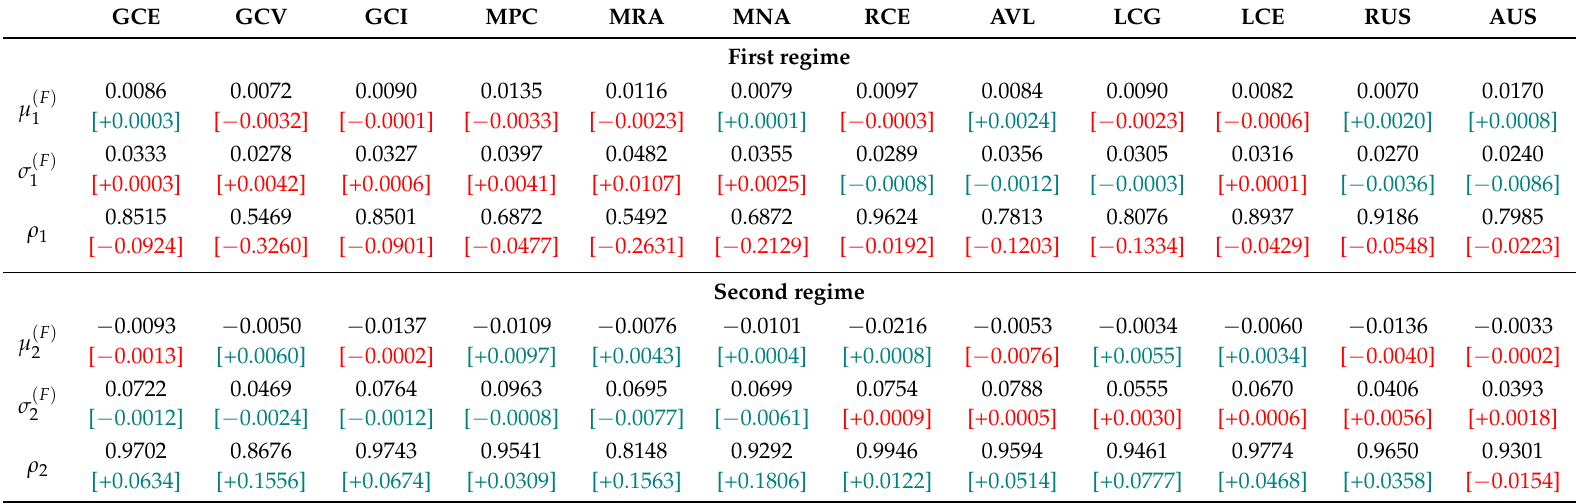
Table 5. Calculation of the fund mapping parameters obtained under constraints (3) for the various funds described in Table 1. The difference compared to the unconstrained model (see Table 2) is given in brackets. Teal brackets indicate an improvement from the perspective of the insurer performing the hedge (i.e., higher mean, lower volatility, or higher correlation), and red brackets indicate a worsening (i.e., lower mean, higher volatility, or lower